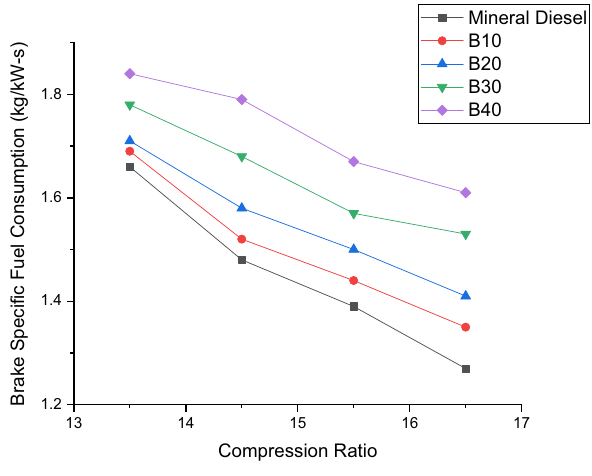
Fig. 8 Variation of BSFC of dual biodiesel sample blends at different compression ratios